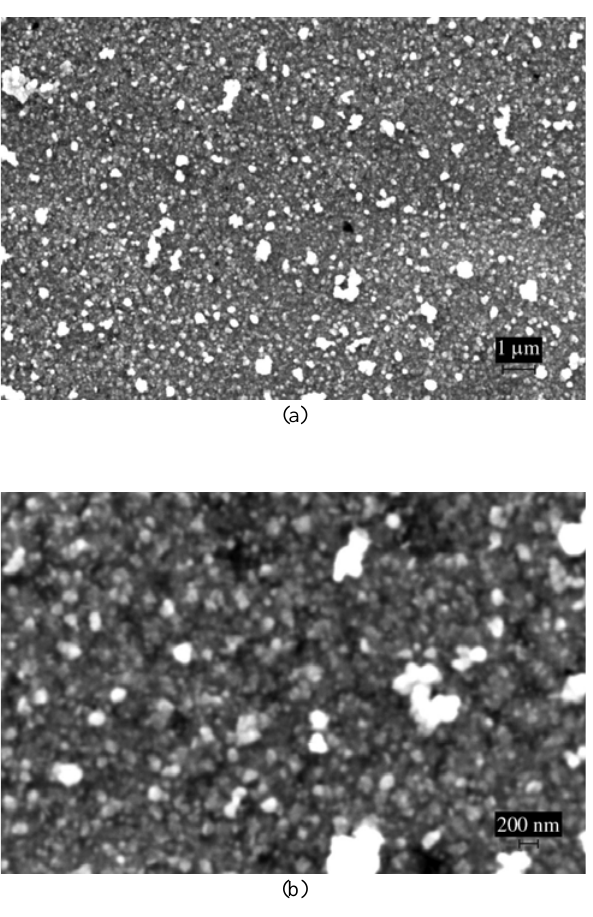
Figure 3. SEM images for PbTe thin films electrodeposited on PSL etched during 3 min at potential of 0.98 V × Ag/AgCl. a) 6.000 X; b) 18.000